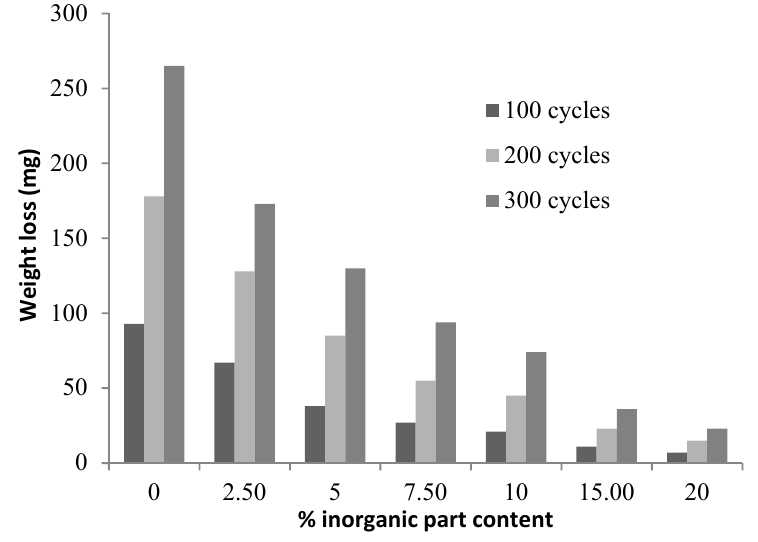
Figure 5. Abrasion resistance of coatings as a function of % inorganic part content.